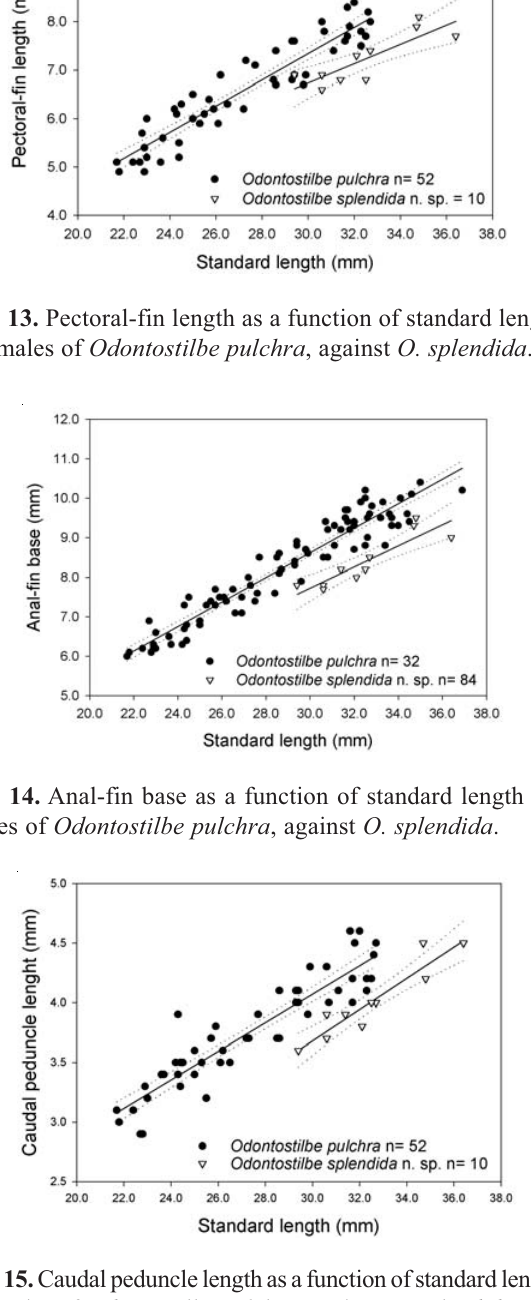
Fig. 15. Caudal peduncle length as a function of standard length for males of Odontostilbe pulchra , against O. splendida .